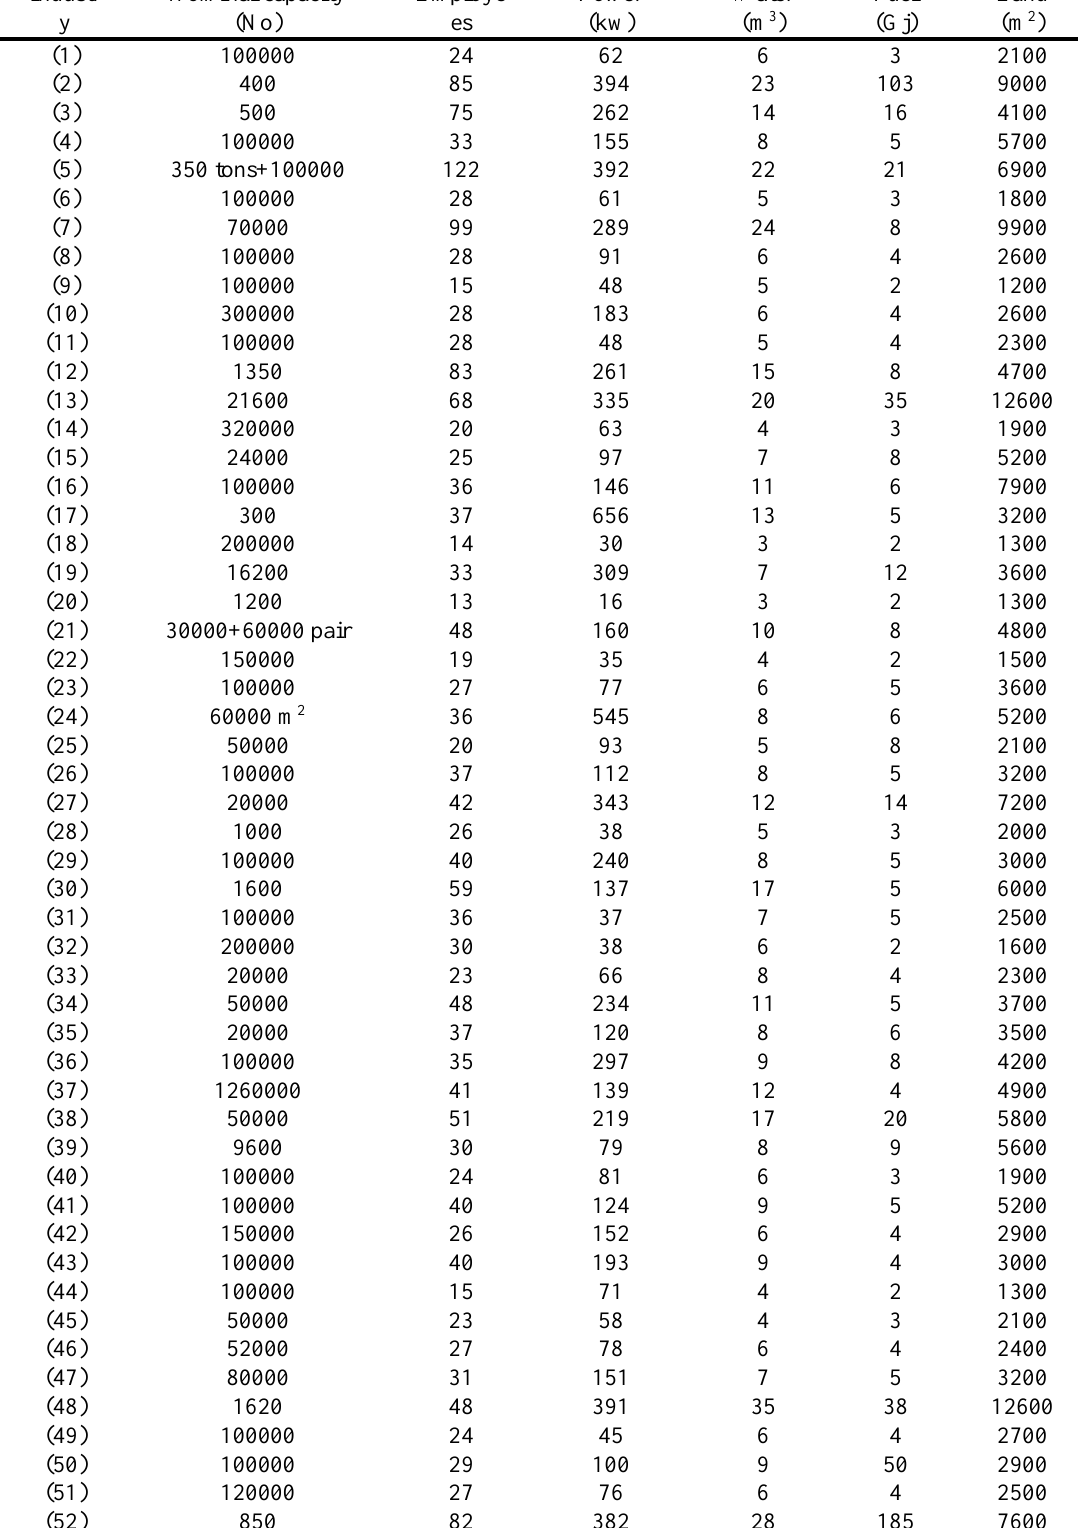
Table 1. IAI, their energy consumptions, staff and, land properties based on nominal capacity.